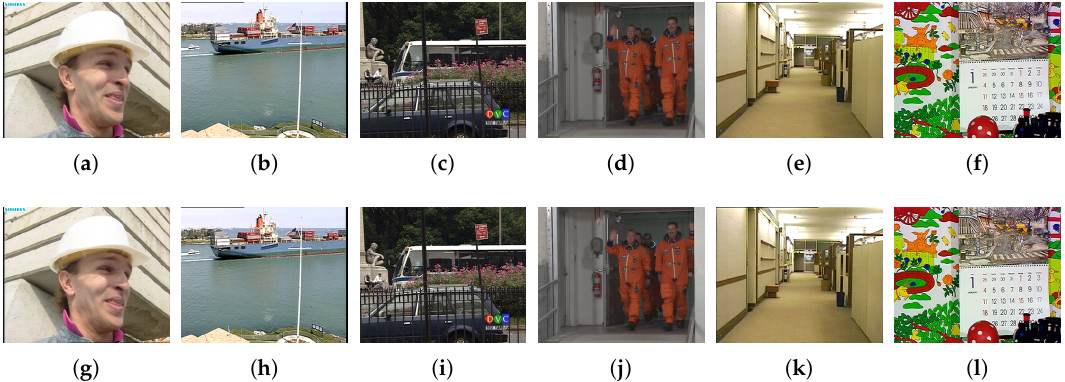
Figure 6. The 10th frame of original videos ( a ) foreman, ( b )container, ( c ) bus, ( d ) crew, ( e ) hall_monitor, and ( f ) mobile, and the corresponding 10th frame of marked videos, where ( g ) marked foreman, ( h ) marked container, and ( i ) marked bus are generated by our scheme using the ( 0,0 ) coefficient pairs; ( j ) marked crew, ( k ) marked hall_monitor, and ( l ) marked mobile are generated by our scheme without using the ( 0,0 ) coefficient pairs,